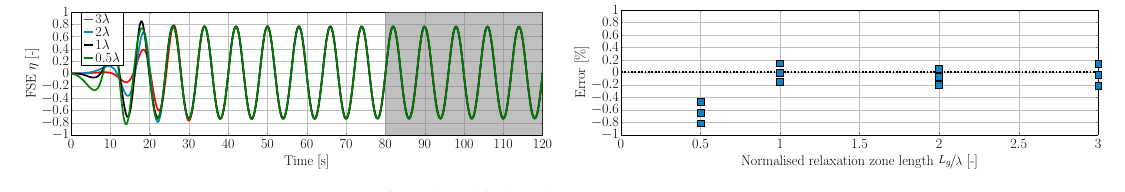
σ ¯ (cid:101) ( b ) for the H ± ¯ H